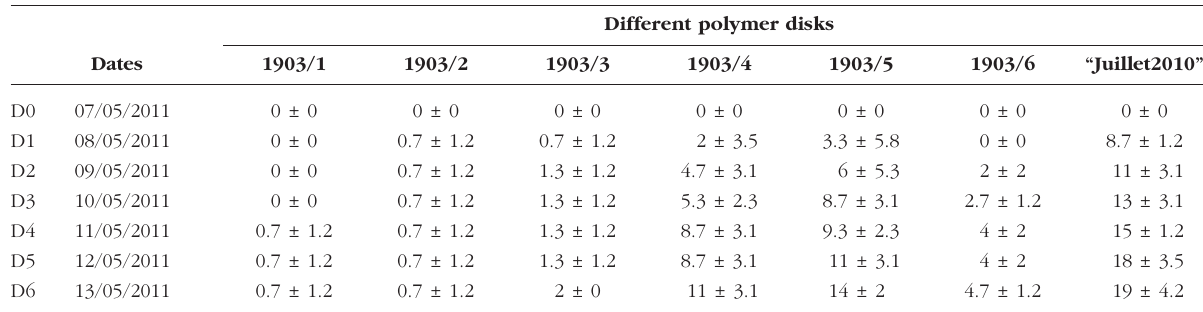
Table II bis. – Experiment A: larval reduction rates (%) of Ae. albopictus with the same geraniol impregnated polymer disks. 1 month after the previous test.